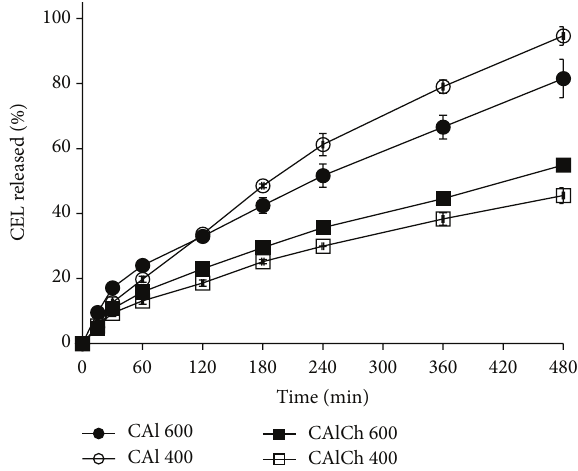
Figure 6: Celecoxib release profiles in hydrochloric acid at pH 1.0.